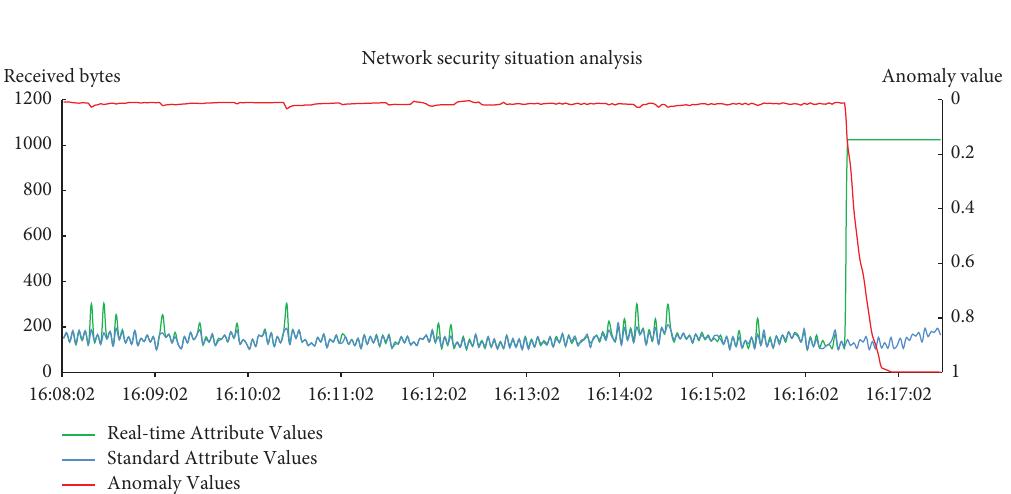
Figure 11: Simulation of the test process of the terminal being